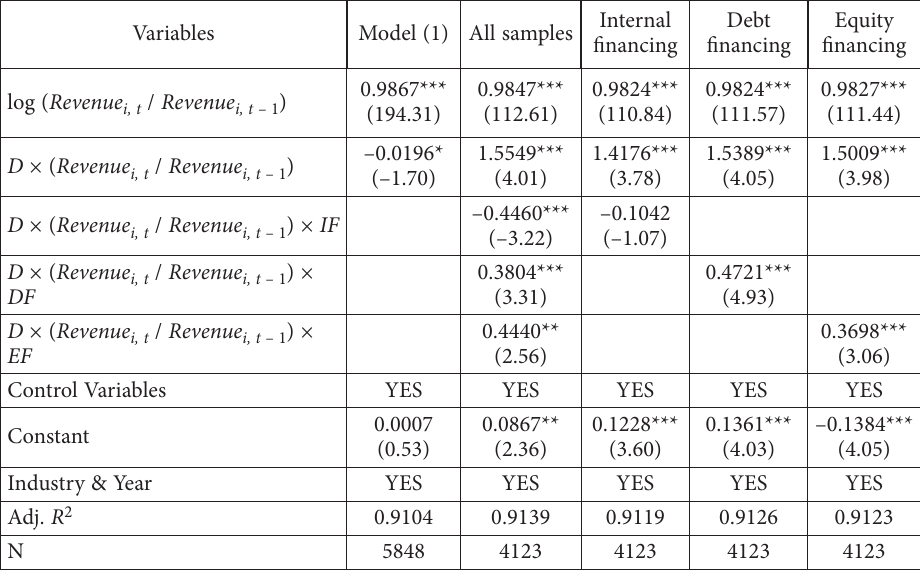
Table 2. Regression results of financing constraints on cost